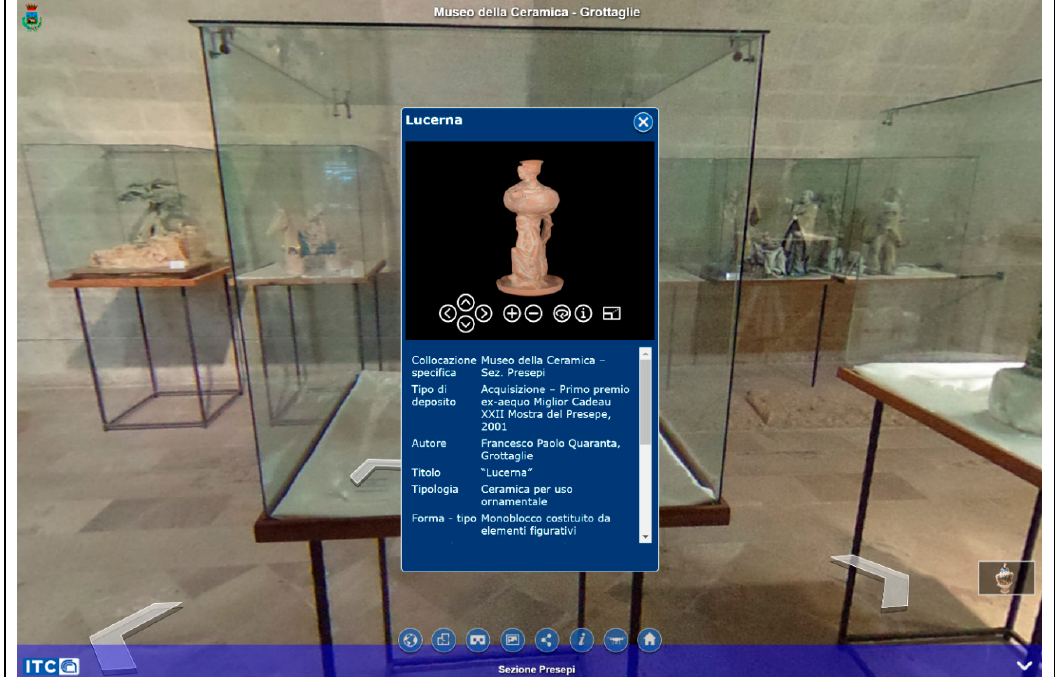
Figure A10: “Museo delle Ceramiche (Grottaglie)”. Command bar, scene previews, object previews, info and 3D, link among scenes; information window, map, stereoscopic view [32].